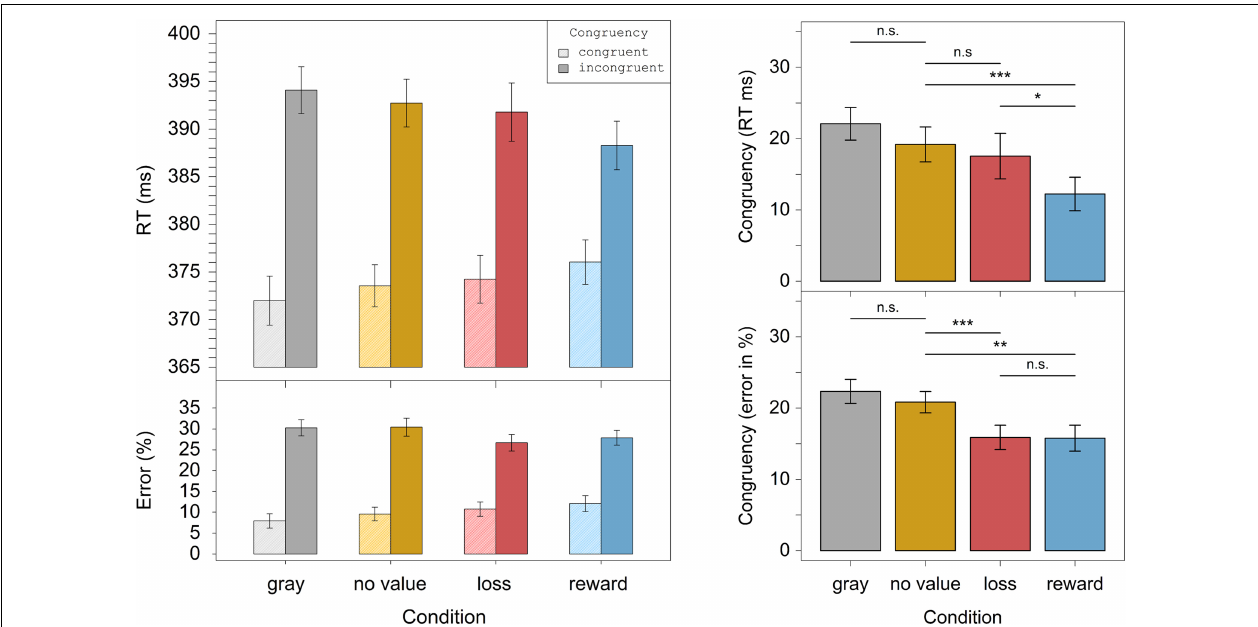
FIGURE 5 | Experiment 2. The left panel displays the RTs and error rates for the different congruency and distractor conditions. The right panel displays differences in the Simon congruency effects for respective pairs of distractor conditions. Displayed are only data from trials in which the deadline was met. Error bars correspond to the within-subject confidence intervals (Morey, 2008). *Significant on p < 0.05, **significant on p < 0.01, ***significant on p < 0.001, n.s. = not